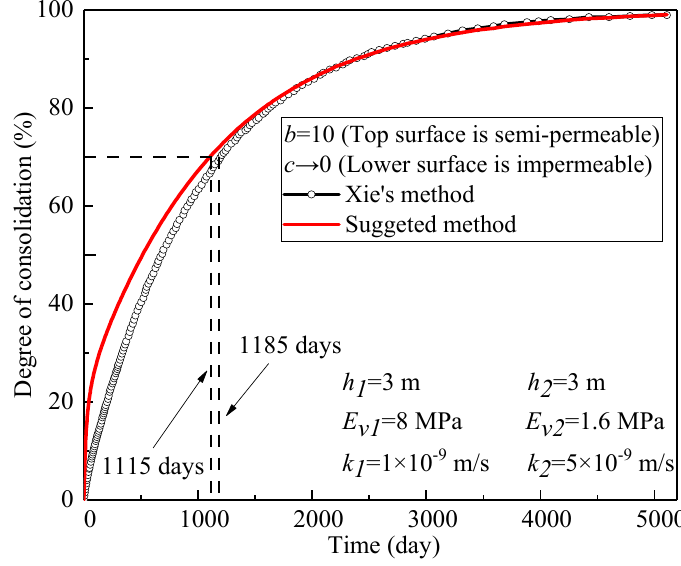
Figure 4. Consolidation curve for the semi-permeable boundary.